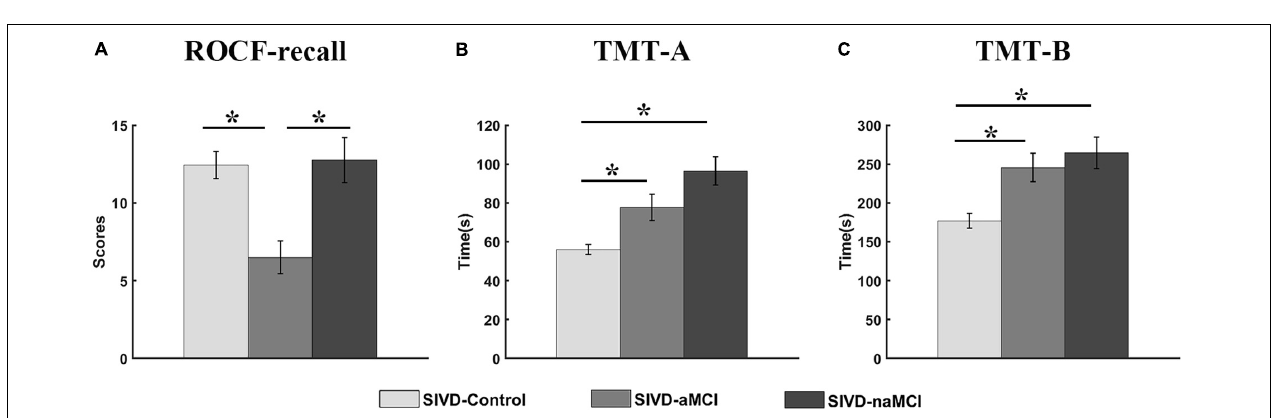
FIGURE 3 | The relationship between the neuropsychological assessments and the measurements of dynamic FC. (A–C) The relationship between ROCF-recall and the mean dwell time of State 3 for SIVD-Control (A) , SIVD-aMCI (B) and SIVD-naMCI (C) . (D–F) The relationship between TMT-A and the mean dwell time of State 3 for SIVD-Control (D) , SIVD-aMCI (E) and SIVD-naMCI (F) .